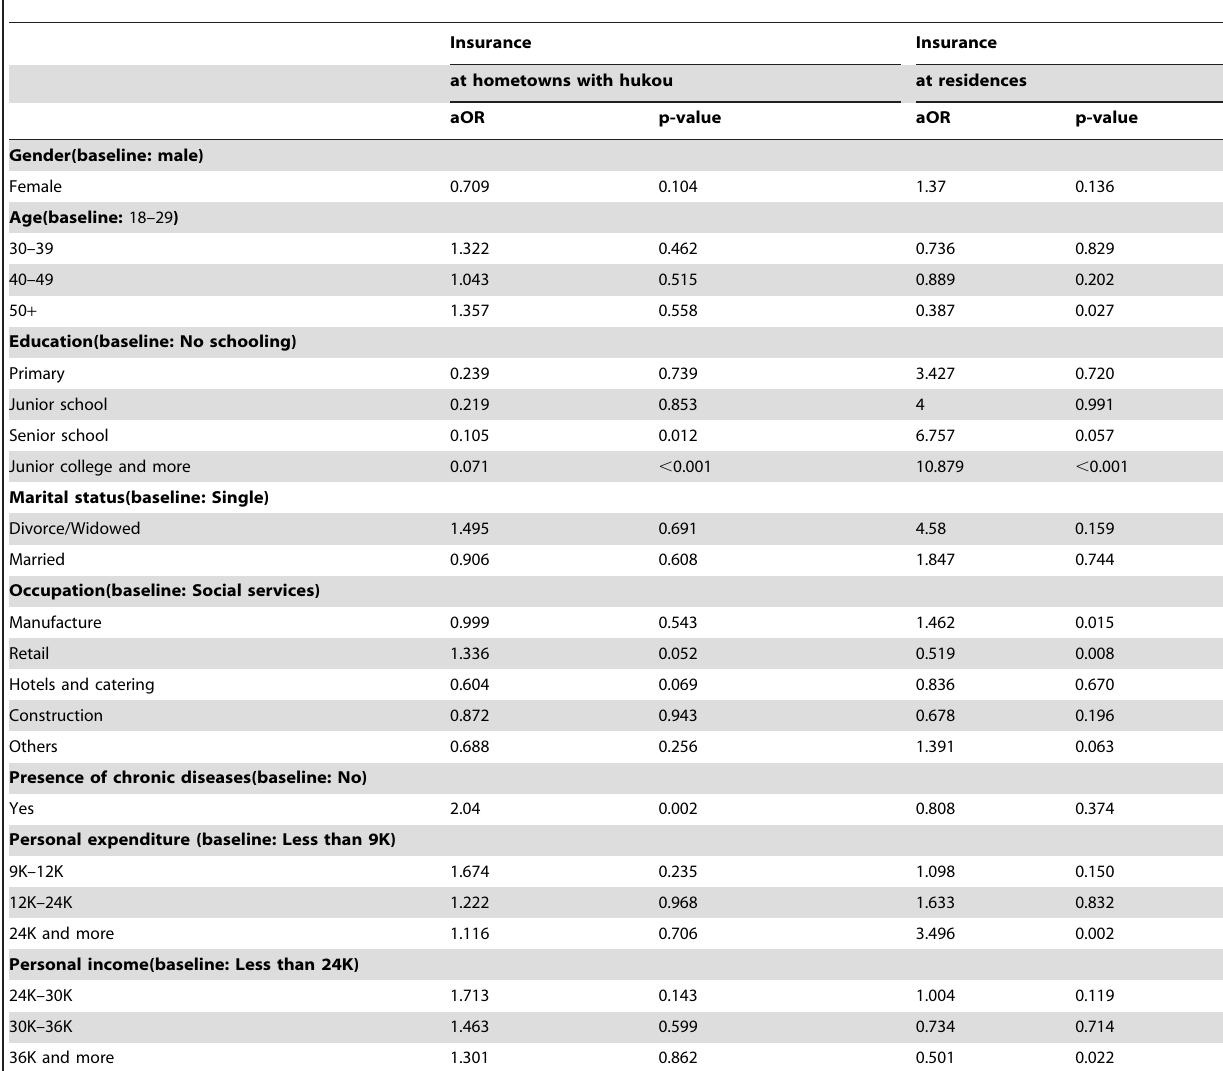
Table 2. Multivariate logistic regression analysis of insurance coverage at hometowns with hukou and residences.